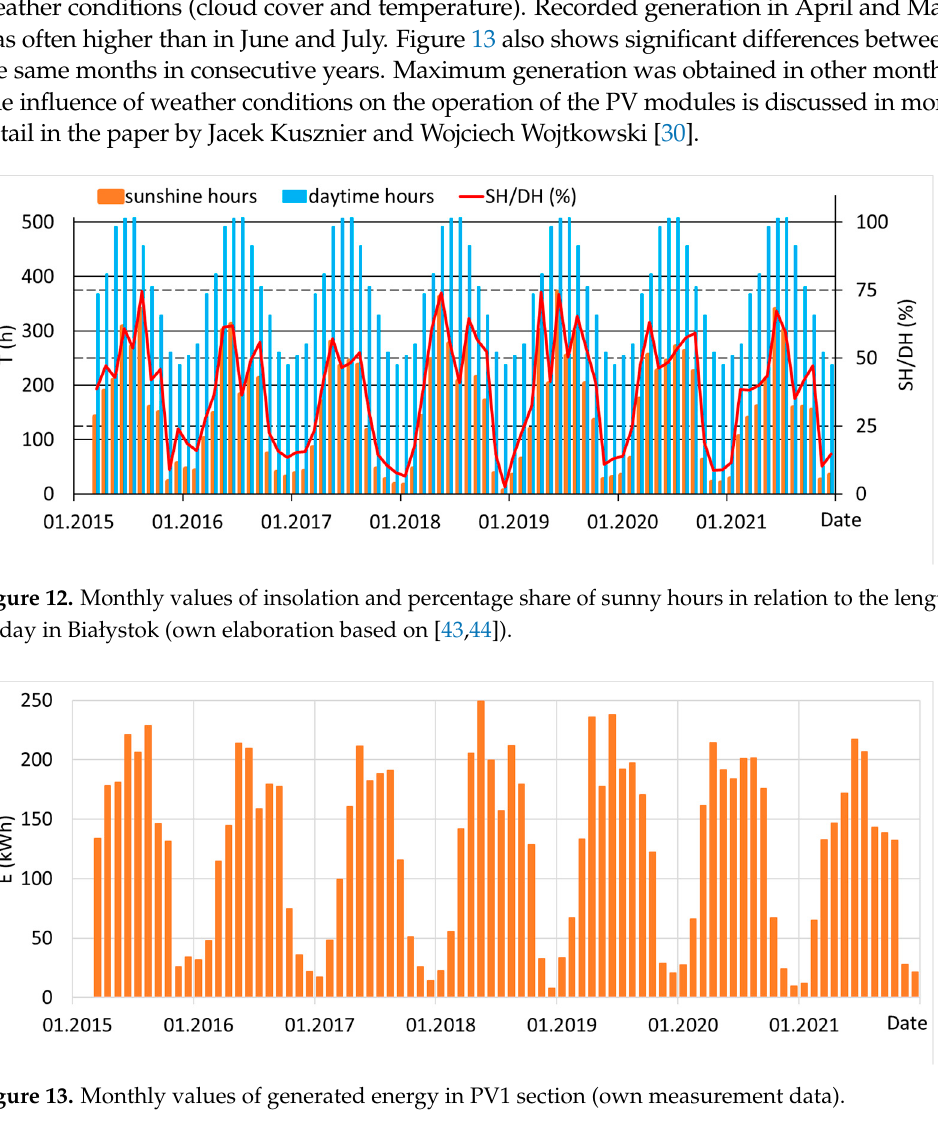
Figure 14. Instantaneous power of analyzed sections on a sunny summer day (own measurement data). Figure 15. Instantaneous power of analyzed sections on a sunny winter day (own measurement data).